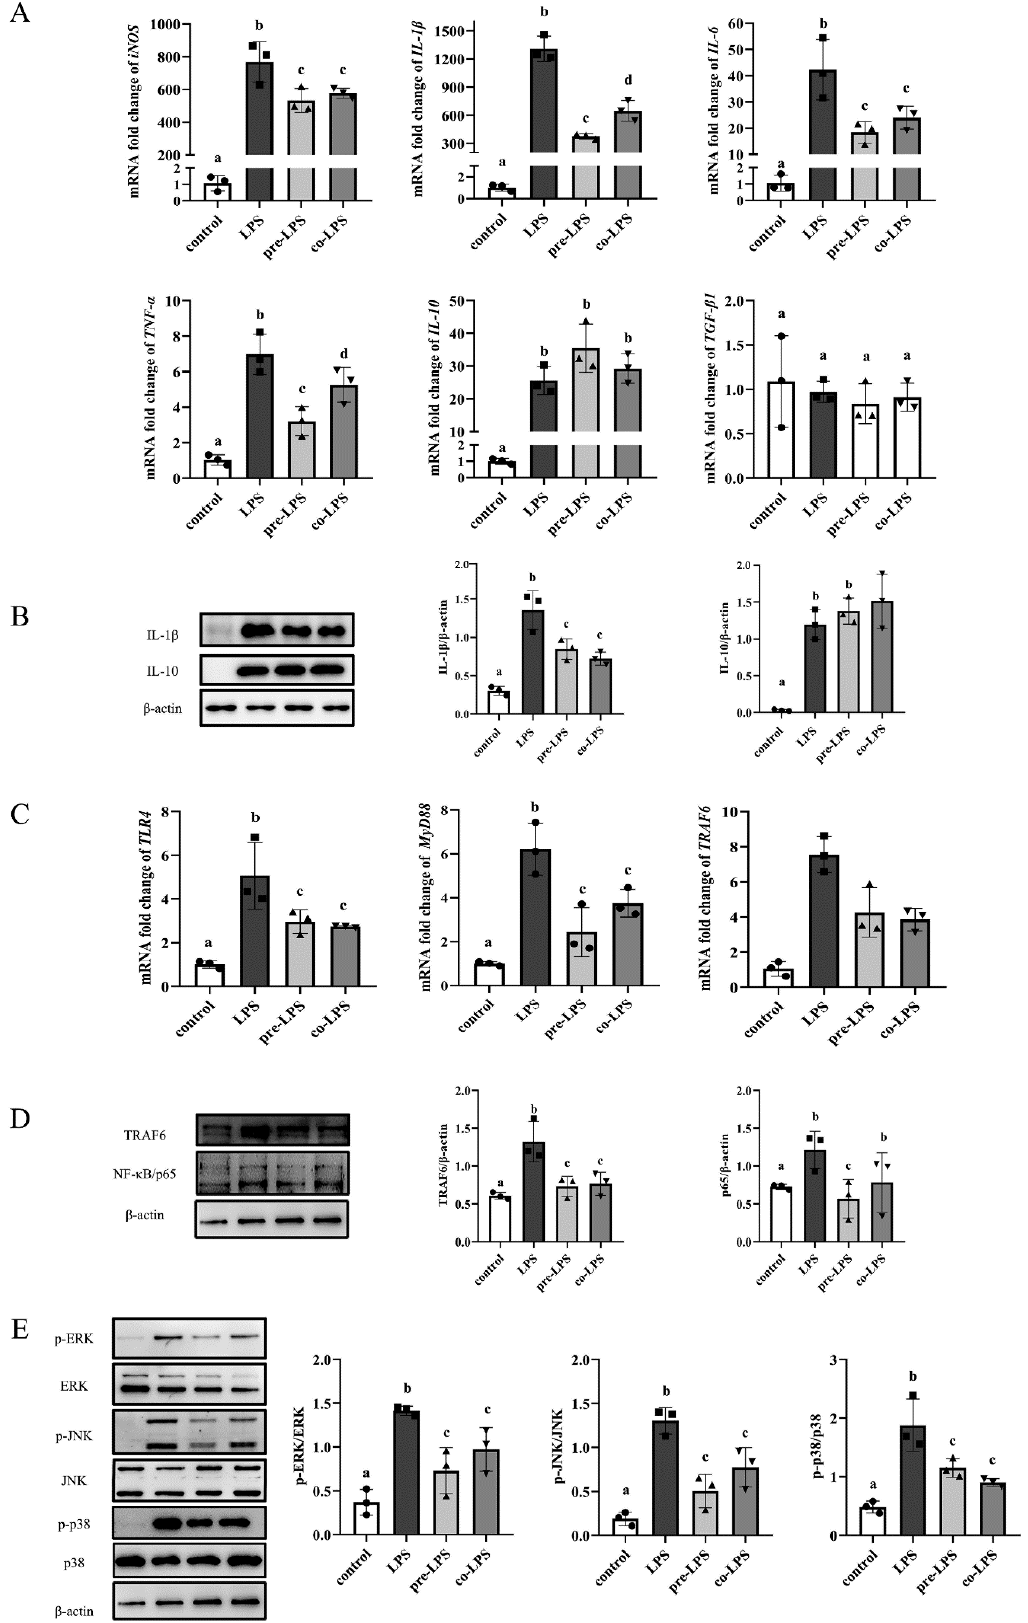
Figure 6. Effects of reuterin on LPS-stimulated inflammation response in HD11 macrophages. HD11 macrophages were cultured in a normal medium (control group) or stimulated with LPS alone for 12